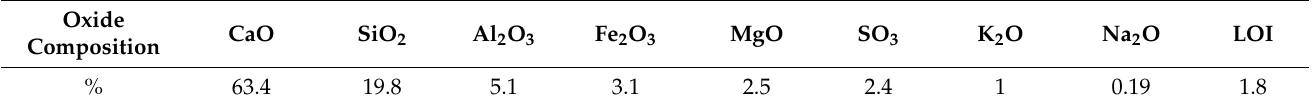
Table 2. Ordinary Portland cement chemical composition